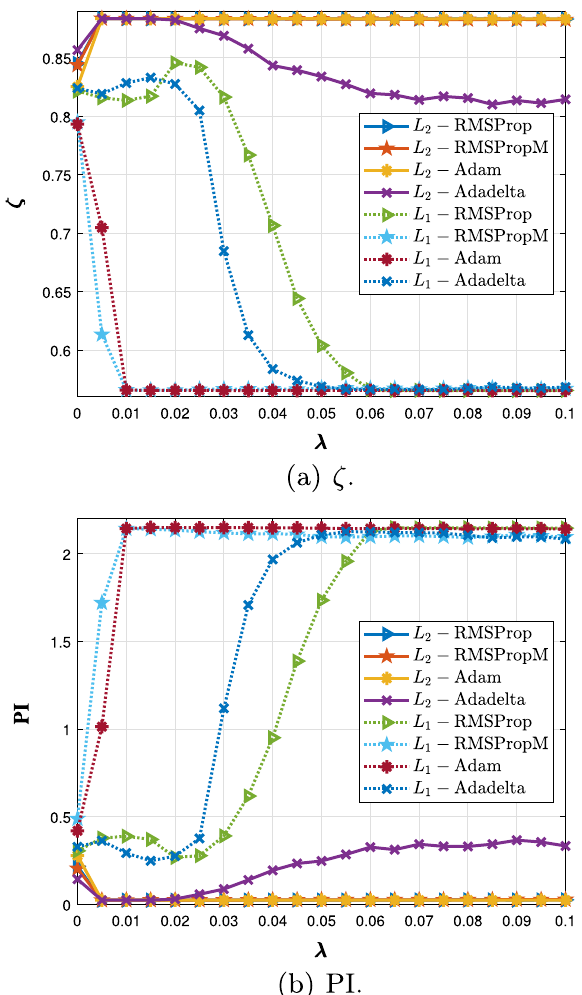
Fig. 5 The separation results in the form of ζ and PI for L 1 and L 2 regularization with SNR regularization parameter (cid:31) changing from 0 to